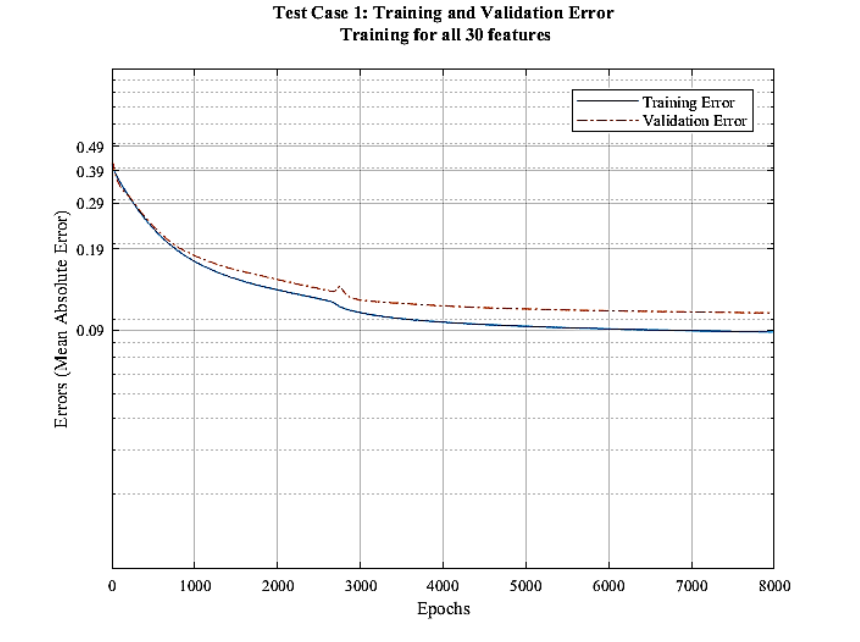
Figure 6. Error vs. epochs graph for test case